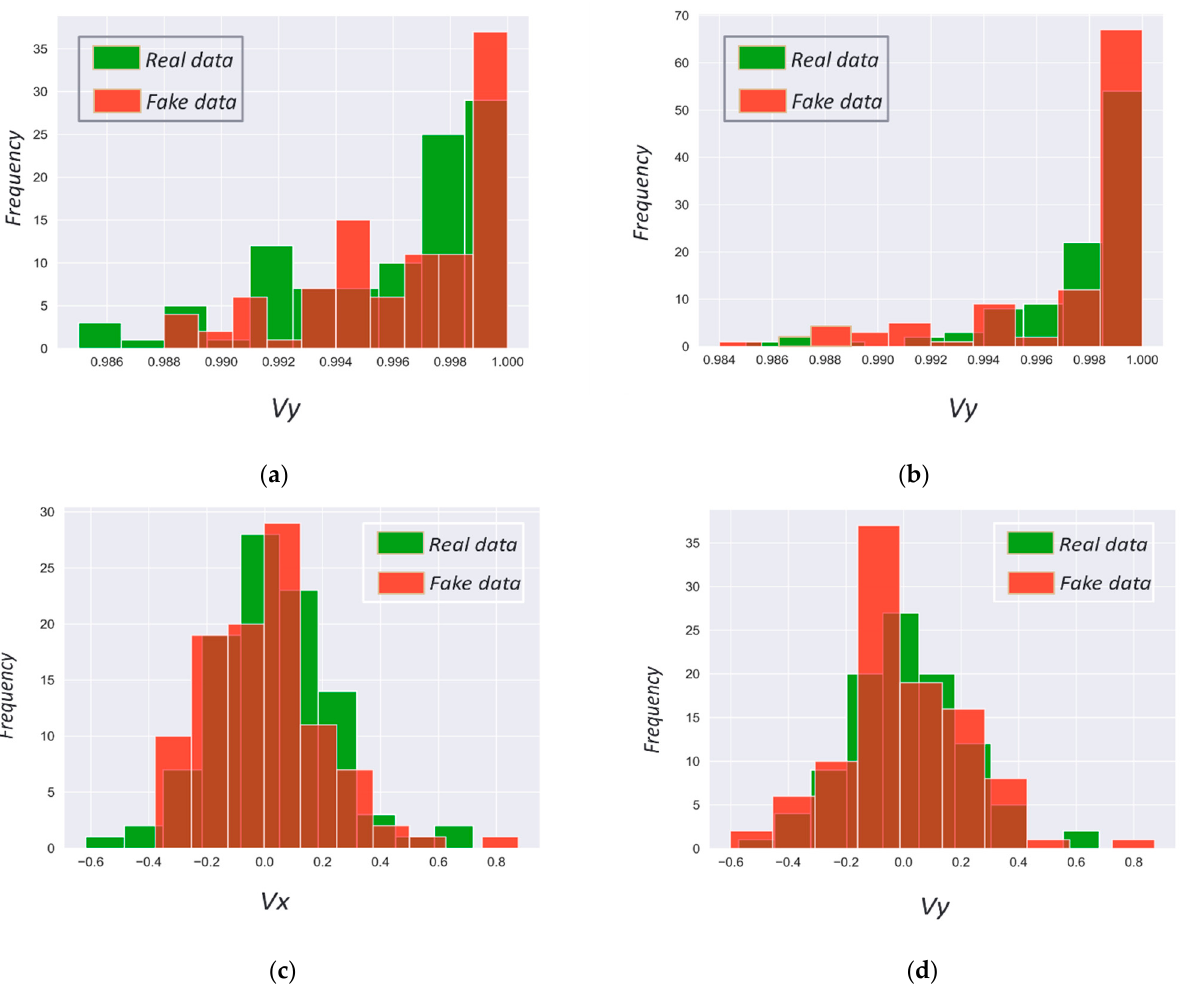
Figure 6. In the histogram of partially generated data and real data, Figures ( a , b ) are the longitudinal speed of the vehicle at the intersection ( a ) and highway ( b ) environment; Figures ( c , d ) are the lateral speed of the vehicle at the intersection ( c ) and highway ( d ) environment. The vehicle’s lateral and longitudinal speeds are normalized.